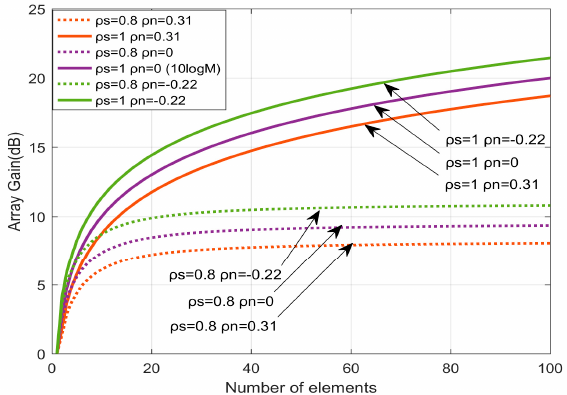
Figure 2. Array gains with variable correlation coefficients of signal and noise.